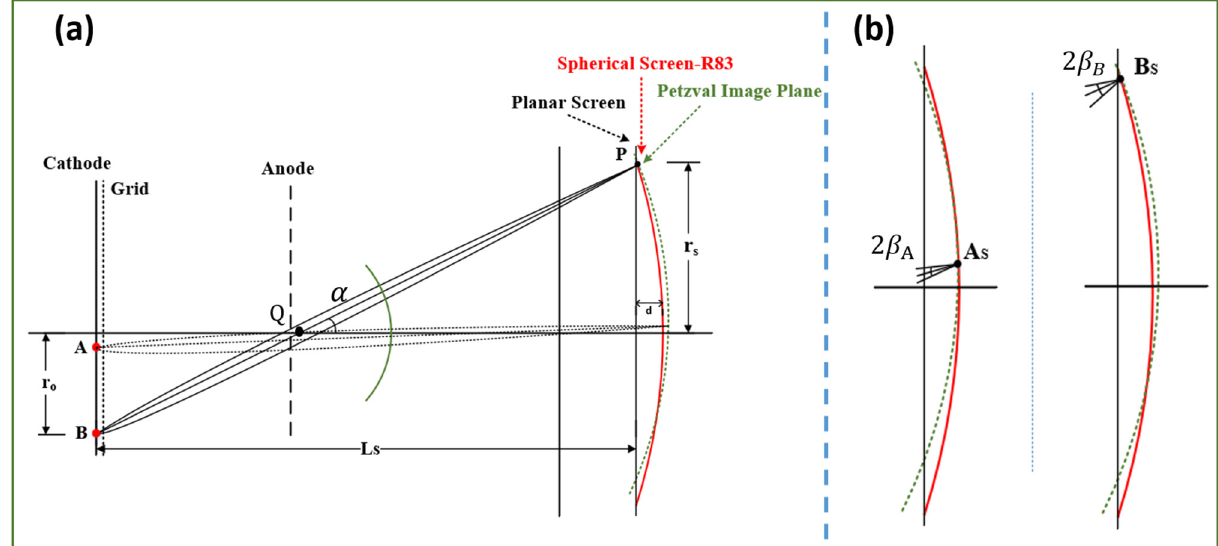
Figure 1. Test schematic diagram: ( a ) Test example; ( b ) A/B points focus best.